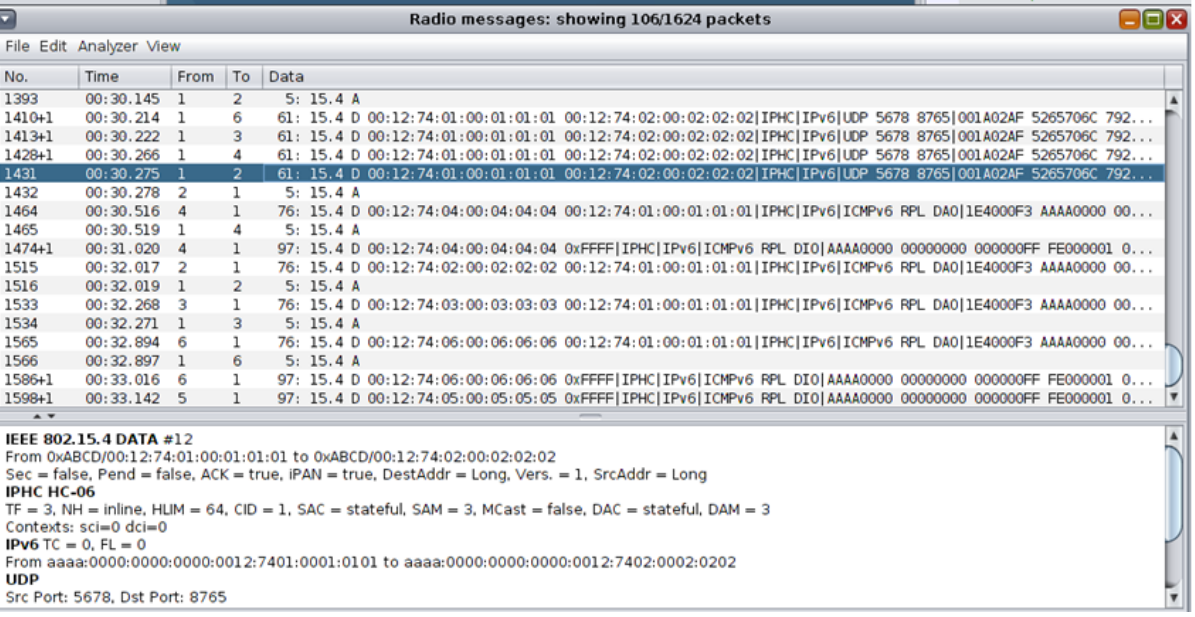
Figure 15. Network traffic information from the benign scenario in t he “Radio messages” output window .